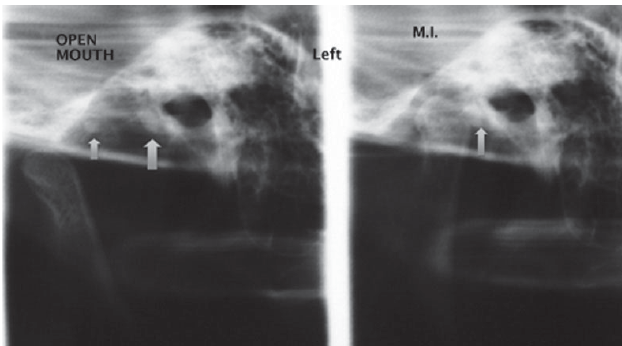
Fig. 2. Case 1. Orthopantomograph of left TMJ: Maximum intercuspation (MI) and open mouth. Arrows point to the loose bodies.